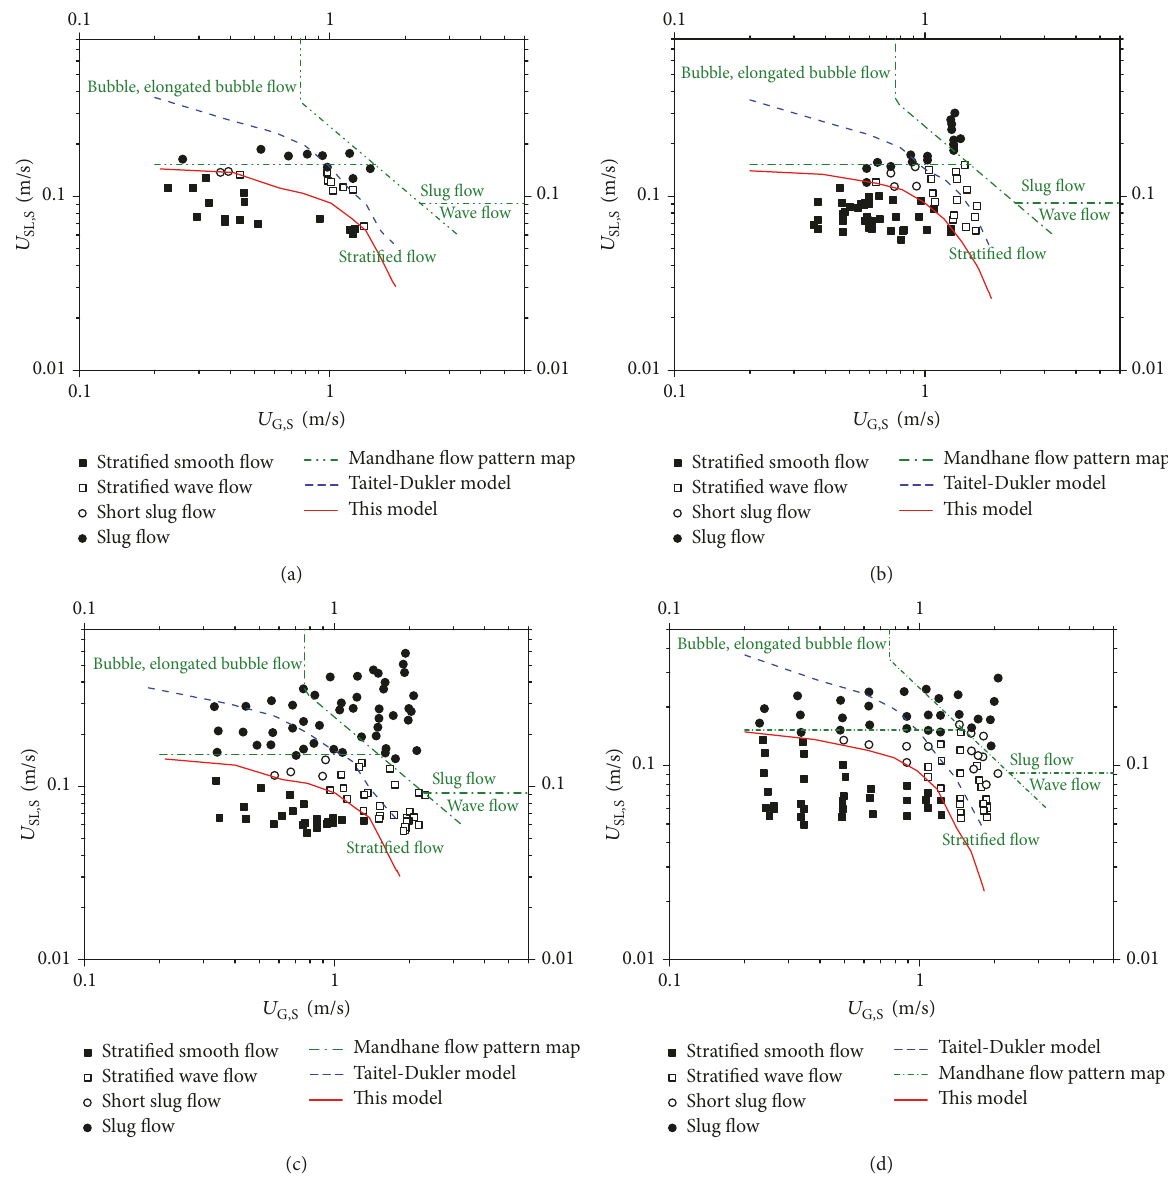
Figure 7: Flow pattern map and boundary for stratified flow of gas-slurry flow at different water cuts: (a) 15%, (b) 20%, (c) 25%, and (d) 30%.